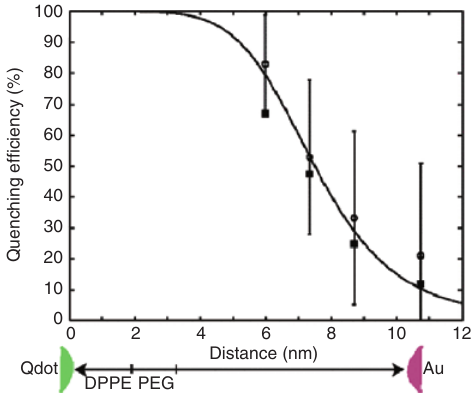
Figure 15: Quenching efficiency of CdSe-ZnS QDs by 1.4 nm AuNPs versus distance separating the particles. Increasing the distance leads to a decrease in quenching efficiency. Adapted with permission from Ref. [33]. Copyright 2004 American Physical